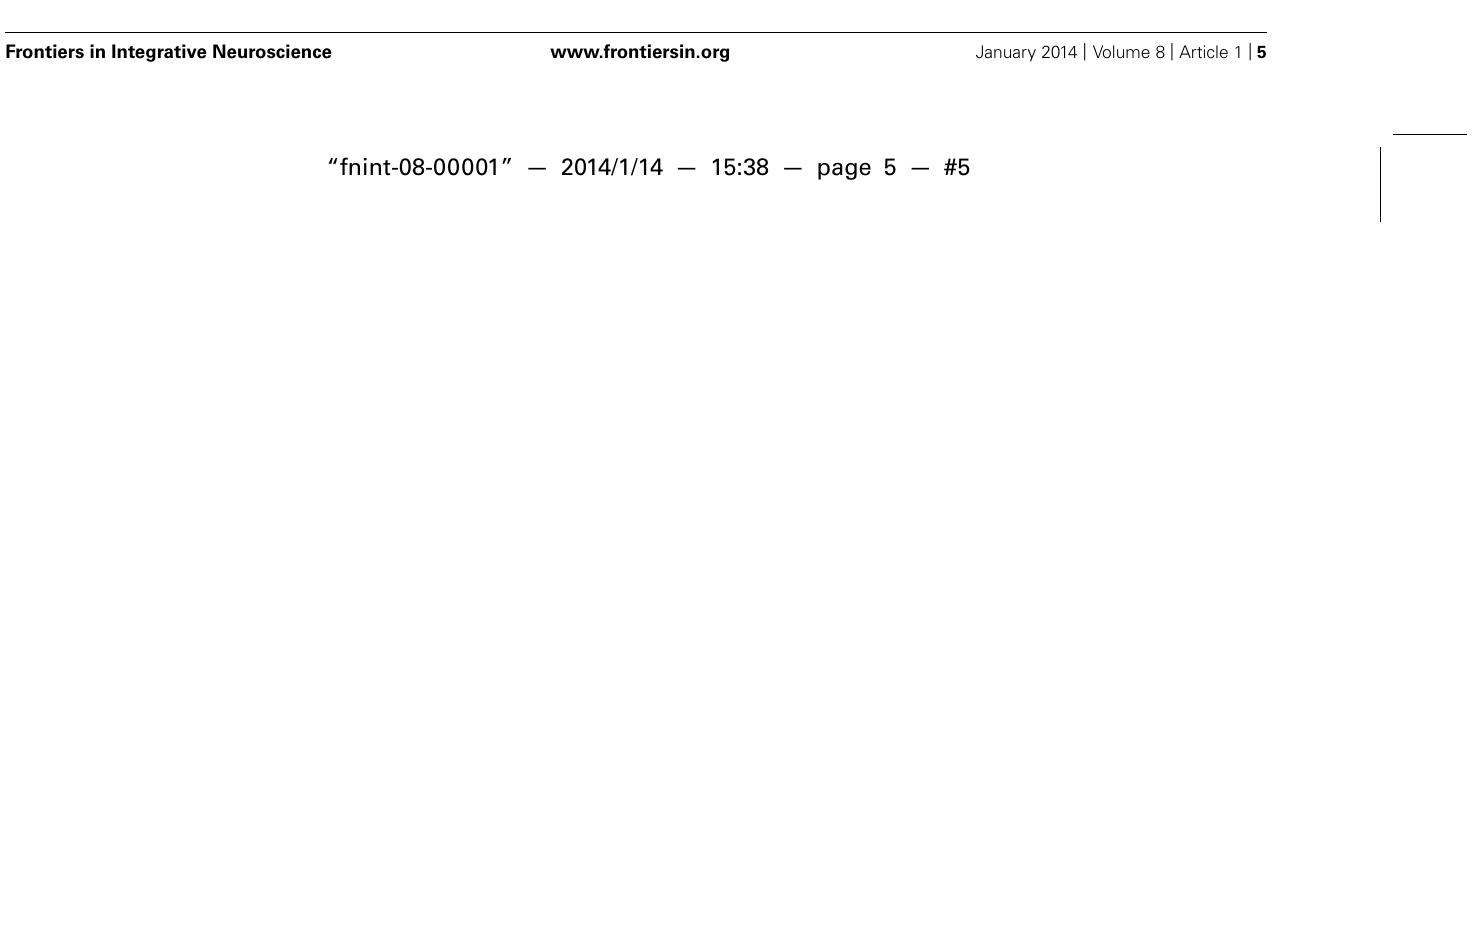
FIGURE 3 | Pupil dilation responses (PDRs) and microstimulation in the OT. (A) The left image shows a zoomed image of a barn owl’s right eye.The image is a video frame taken from an infra-red sensitive video sequence showing the infra-red light reflected from the retina.The arrow points to the edge of the pecten, a retinal landmark absorbing light.The image on the left shows a similar video frame after processing and fitting the pupil edge with an ellipse.The red circle designates the fitted pupil edge.The cross designates the center of the circle and the blue line shows the horizontal edge of the pecten.The diameter of the circle and the average horizontal position of the pecten edge were used to measure pupil dilations and eye movements. (B) The graph shows PDRs to three consecutive auditory stimuli given every 12 s.The solid line designates the response to the first stimulus, the dashed line the response to the second stimulus and the dotted line the response to the third stimulus.The base line of all response profiles was reduced to zero level.The horizontal bar indicates the duration of the acoustic stimulus and the vertical line the onset of stimulation. (C) Results of coupling acoustic and tectal electrical stimulation.The inset shows the time course of